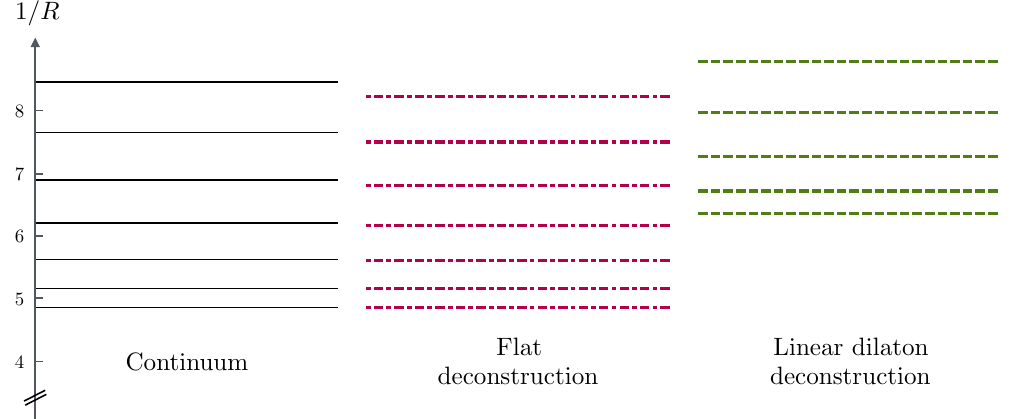
Figure 3 . Left: spectrum of massive KK-modes for a massless scalar (cid:12)eld in a linear dilaton geometry given by X ( y ) = Y ( y ) = e (cid:0) 4 ky , which is identical to that of a scalar (cid:12)eld in a (cid:13)at background with bulk mass M 2 = 3 k , and boundary mass parameter ~ m (cid:30) = (cid:0) 6 k . Center: spectrum (cid:30) of clockwork gears arising from the deconstruction of a massive scalar (cid:12)eld in a (cid:13)at background. Right: spectrum of clockwork gears arising from the deconstruction of a massless scalar (cid:12)eld in a linear dilaton geometry. For illustration, we take k(cid:25)R = 5 in all three cases, and the center and right (cid:12)gures correspond to deconstructions featuring N = 30